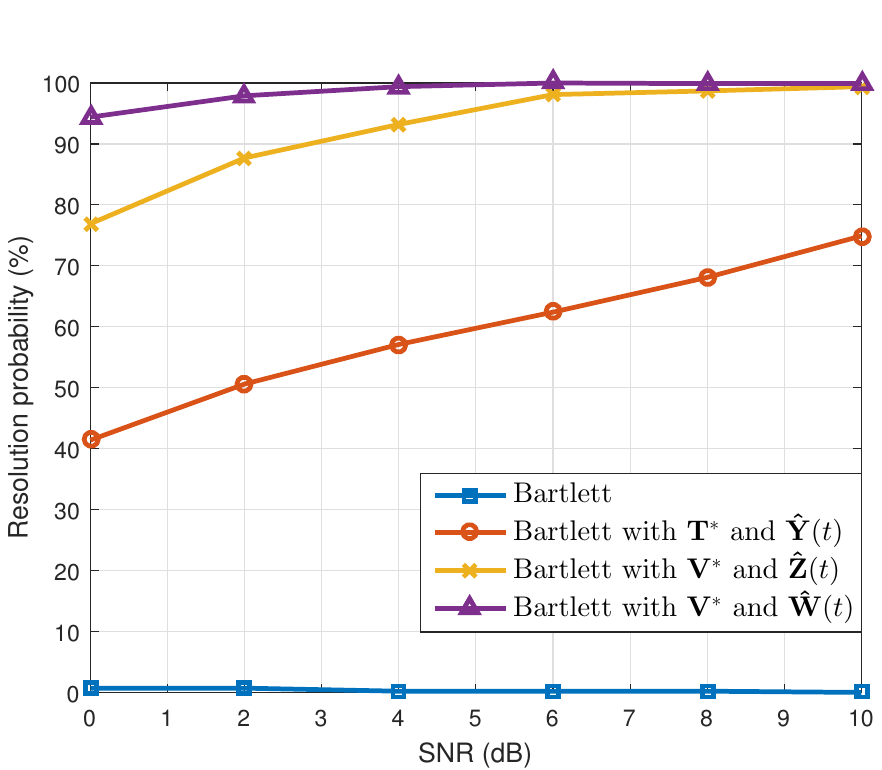
Figure 3. Resolution probabilities versus SNR ( N =